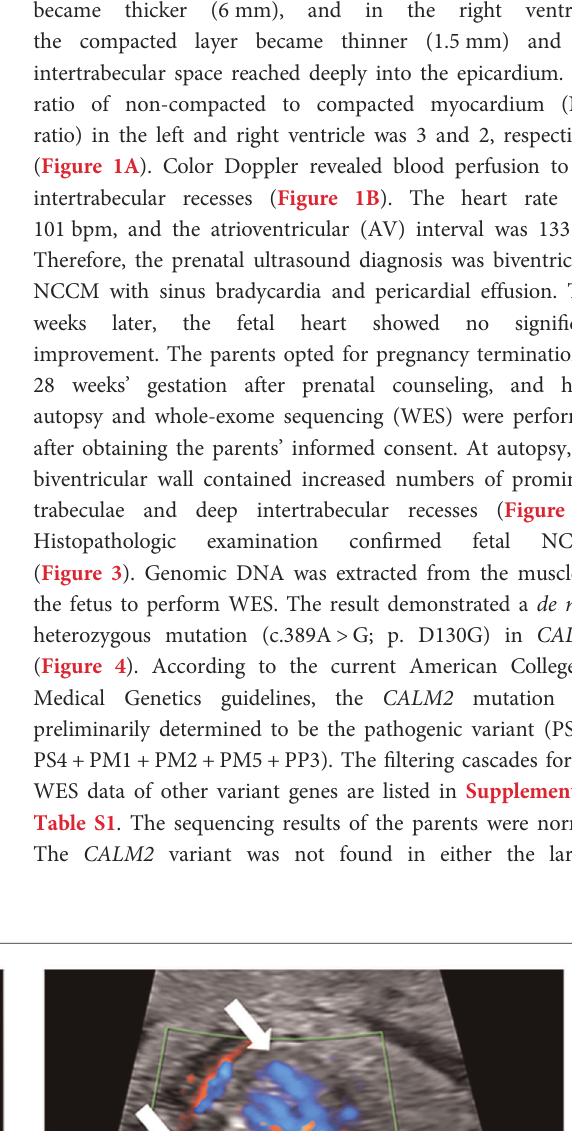
( Figure 1A ). Color Doppler revealed blood perfusion to the